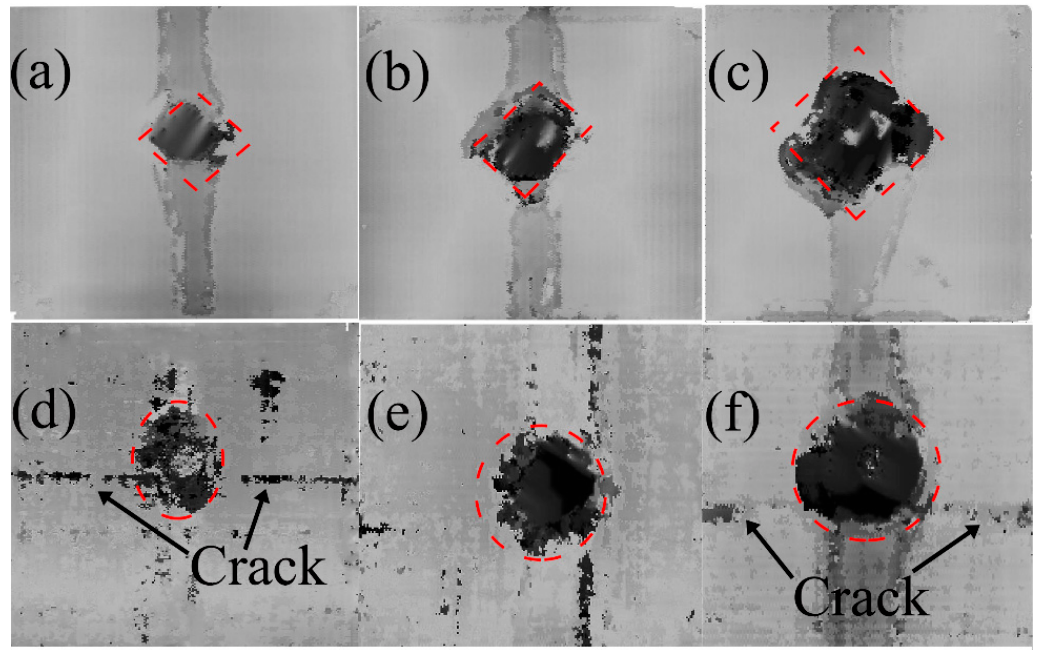
Figure 11. C-scan characteristic of the specimen after the impact velocities of ( a ) 45 m/s, ( b ) 68 m/s, and ( c ) 86 m/s in “dry” and of ( d ) 45 m/s, ( e ) 68 m/s, and ( f ) 86 m/s in “wet” for the cone-ended projectile.